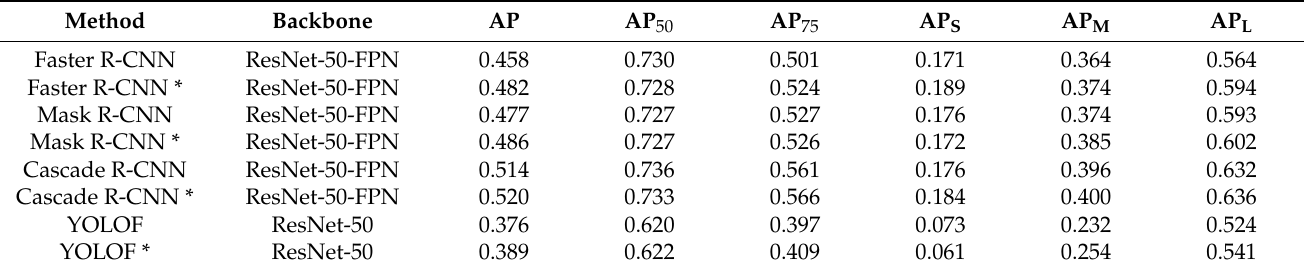
Table 3. The performance when incorporating the EfocalL1-SEIOU loss with different SOTA